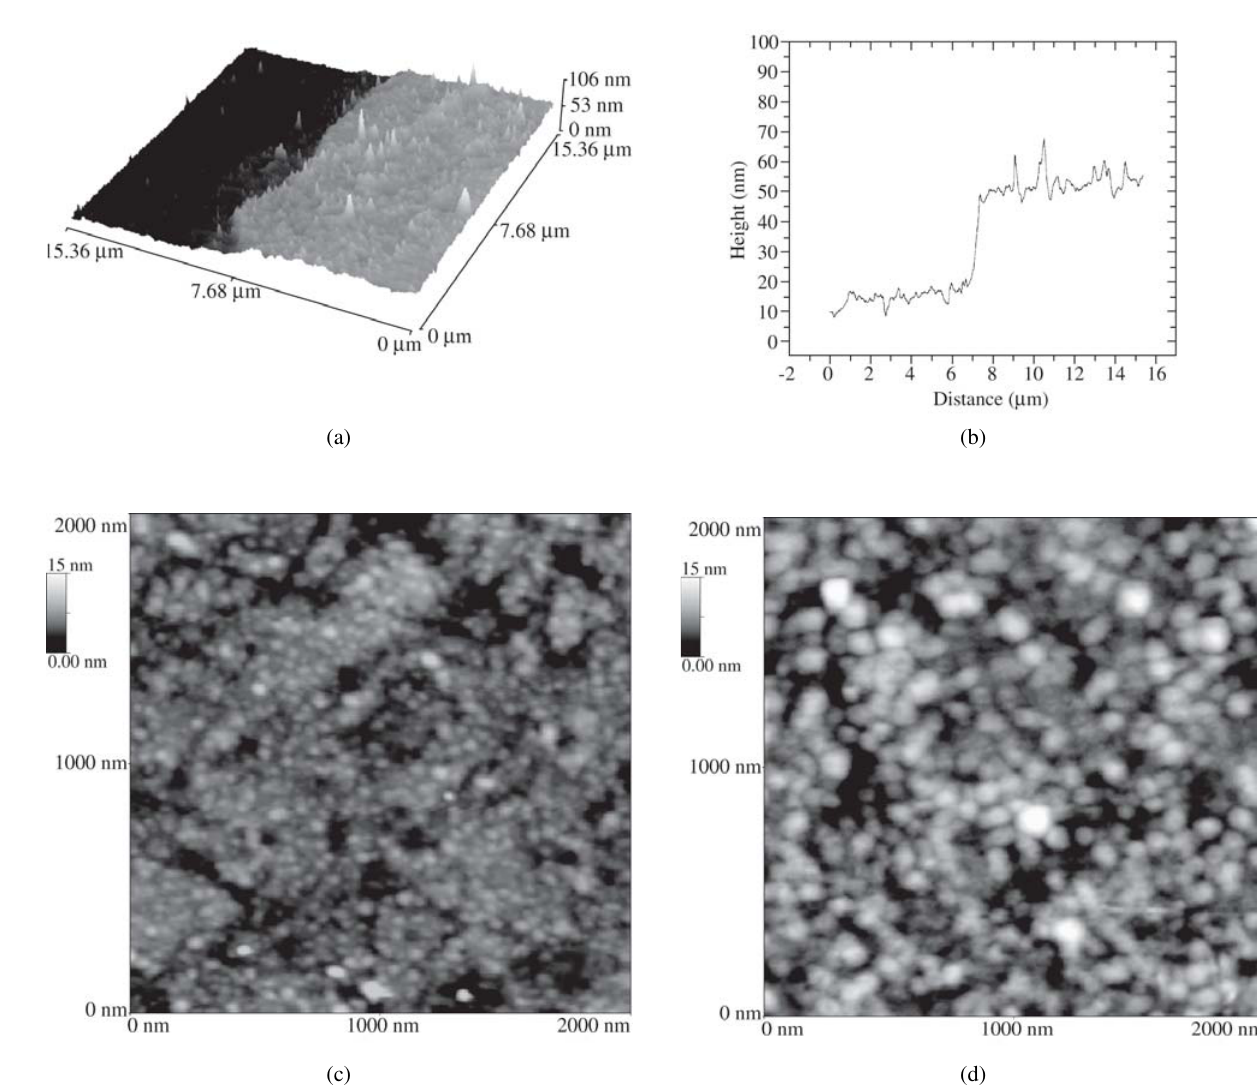
Figure 4. Anodized film produced by electrolytic etch on the half surface of commercially pure titanium sheet: a) 3D view. Darker region corresponds to polished titanium surface; b) Line profile on interfacial region from Fig. 4a; c) Image (2 µ m × 2 µ m) of natural oxide film; d) Image (2 µ m × 2 µ m) of anodized oxide